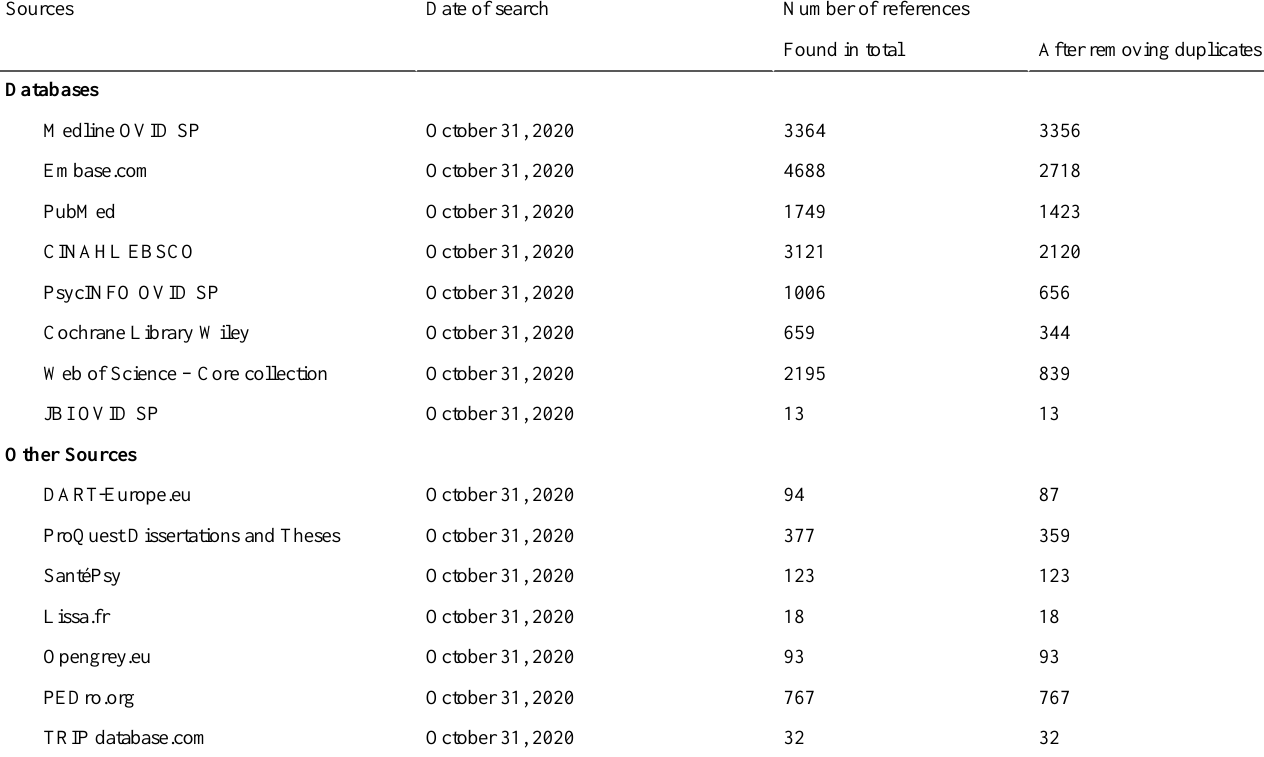
Table 1. Number of references retrieved with the search